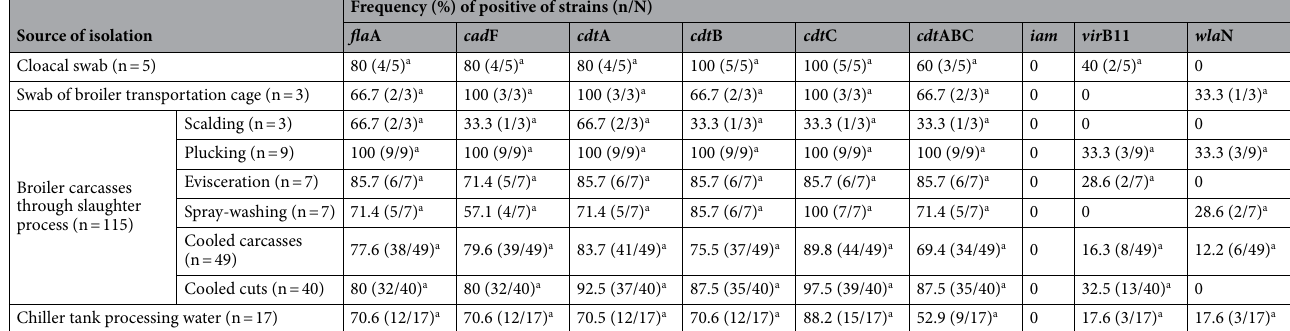
Table 2. Distribution of virulence markers among Campylobacter jejuni strains, according to the source of isolation. Different letters in the same column indicate significant differences ( p < 0.005) among source of isolation (Fisher’s exact test; adjusted p